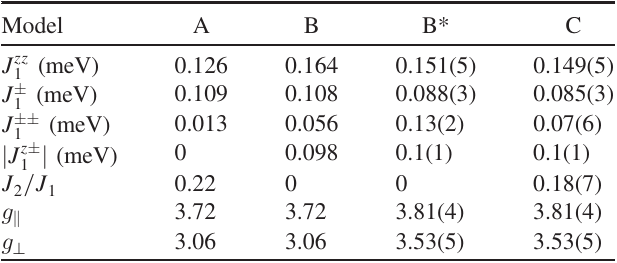
TABLE I. Exchange parameters for different models derived from fitting the spin-wave dispersions. Models A and B are from Ref. [61] and Ref. [43], respectively. Model C is from our global fit to the TDTS and INS data. Model B* is from a global fit to the data by ignoring NNN interactions, i.e., J 2 ¼ 0 . Uncertainties in the values represent the 99.7% confidence interval (3 s.d.) in extracting the fitting parameters.